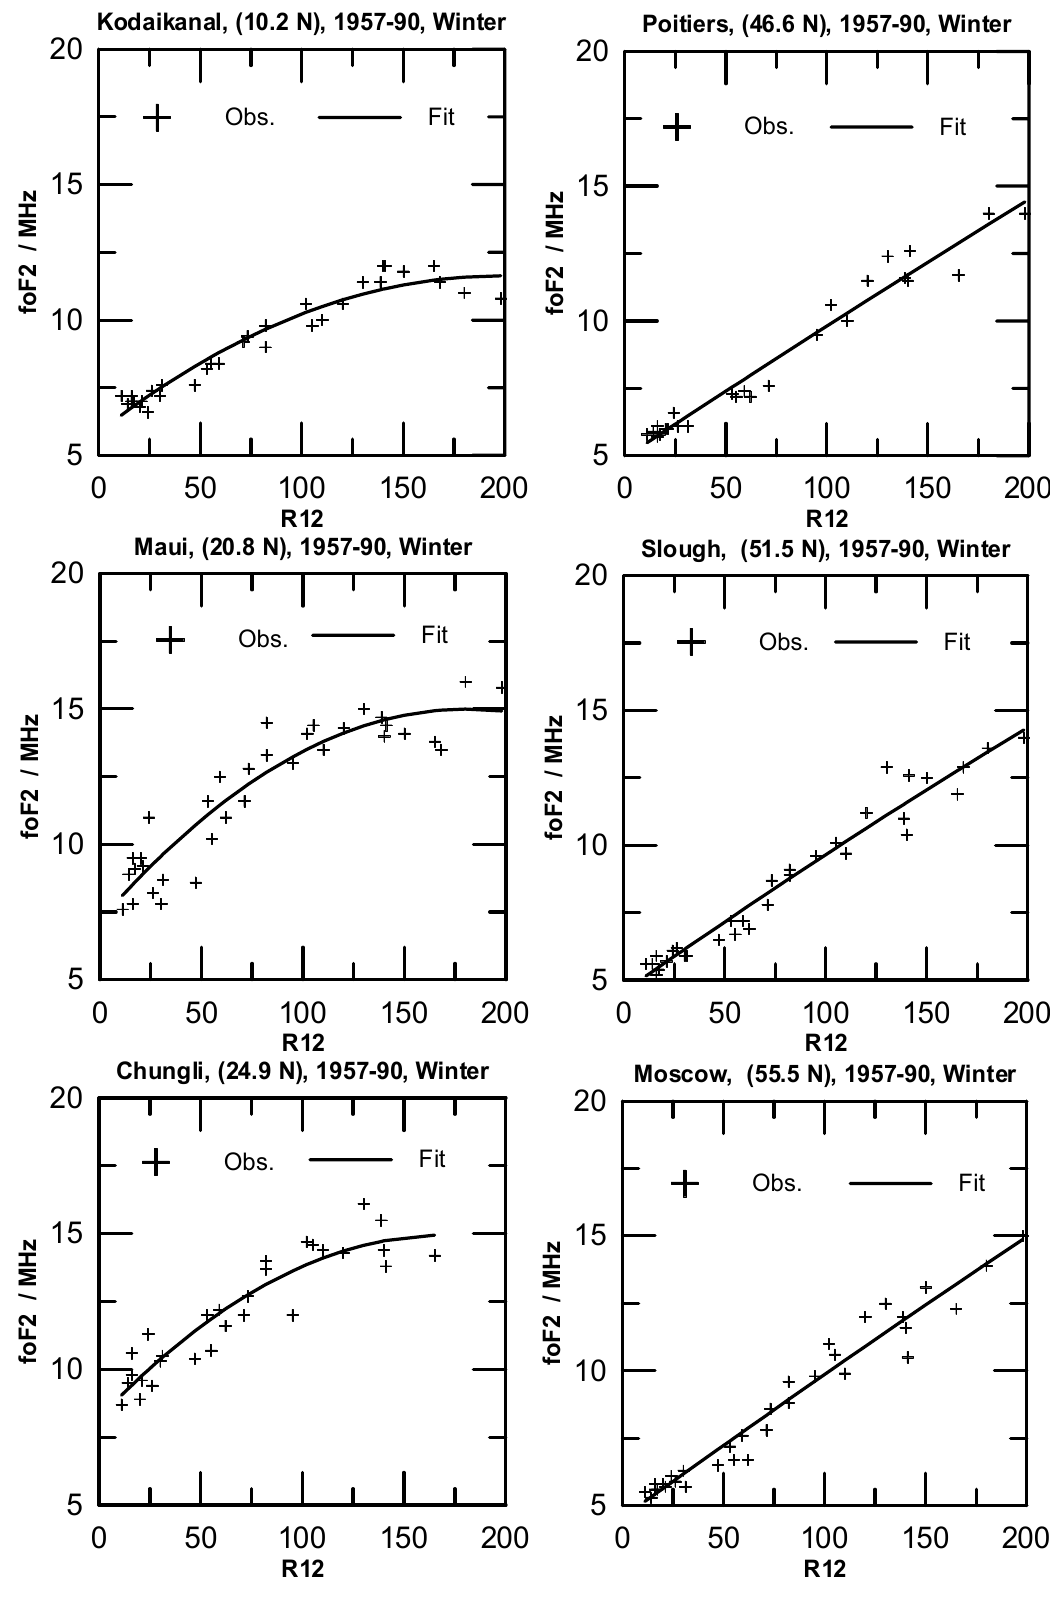
Fig. 2. Same as Fig. 1 but for